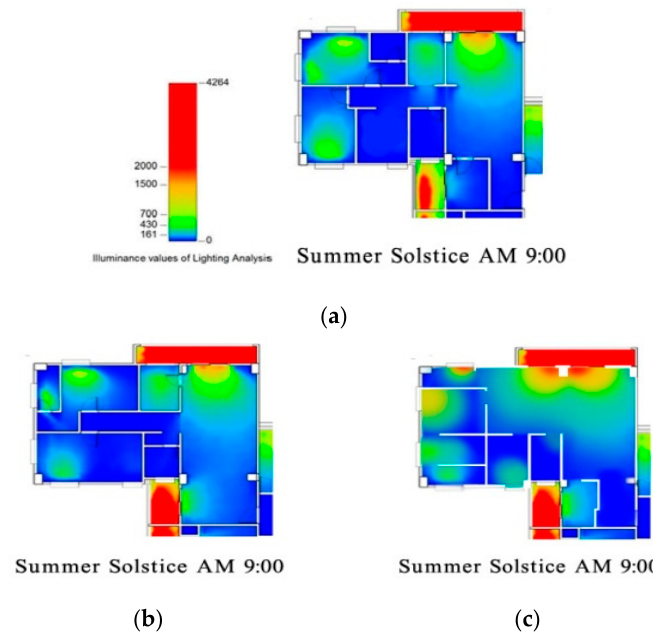
Figure 5. Indoor illumination simulation of design proposal targeting 100 years. ( a ) After the first adjustment; ( b ) after the second adjustment; ( c ) after the third adjustment.